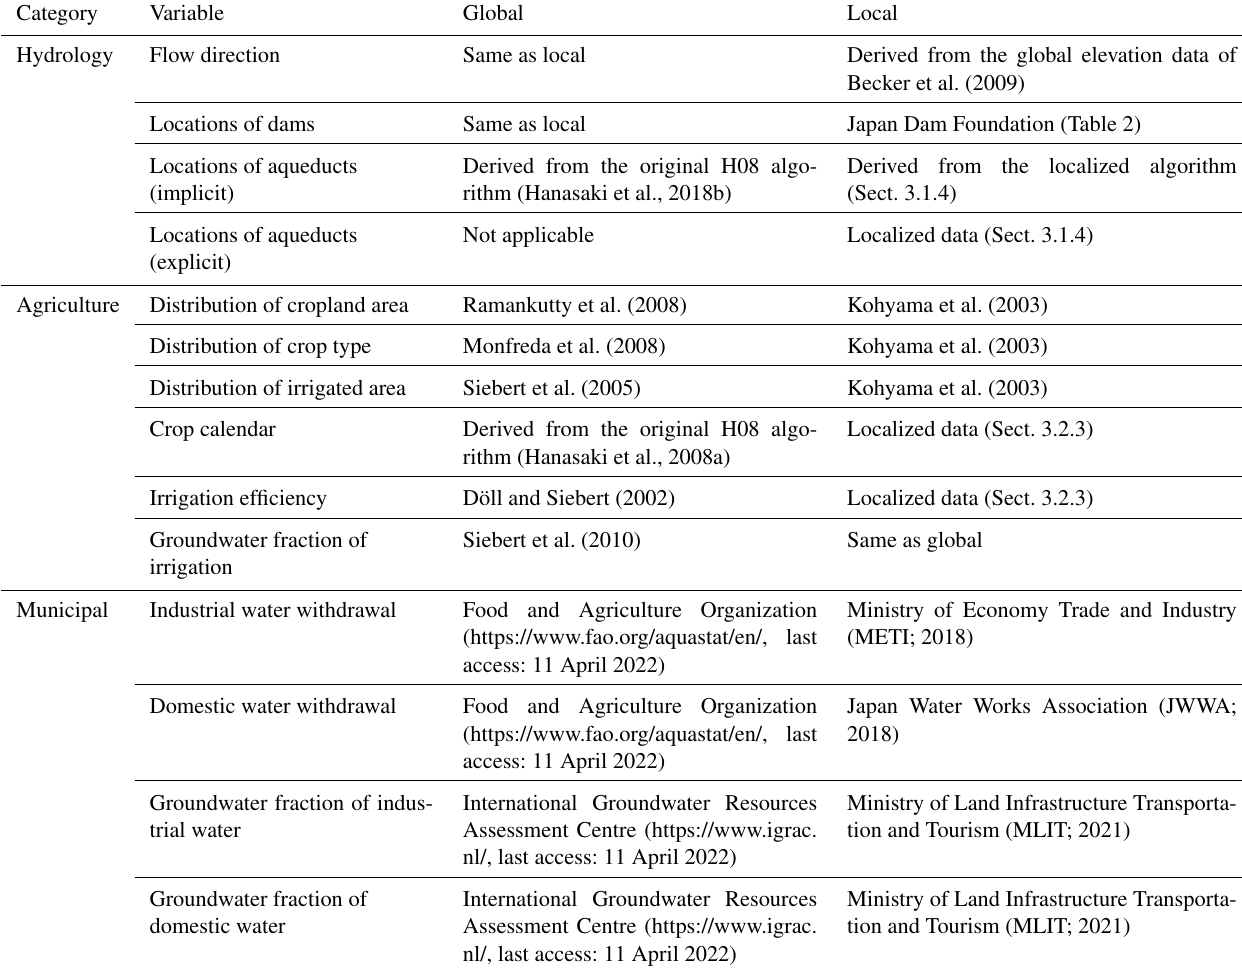
Table 3. Geographic data used in this